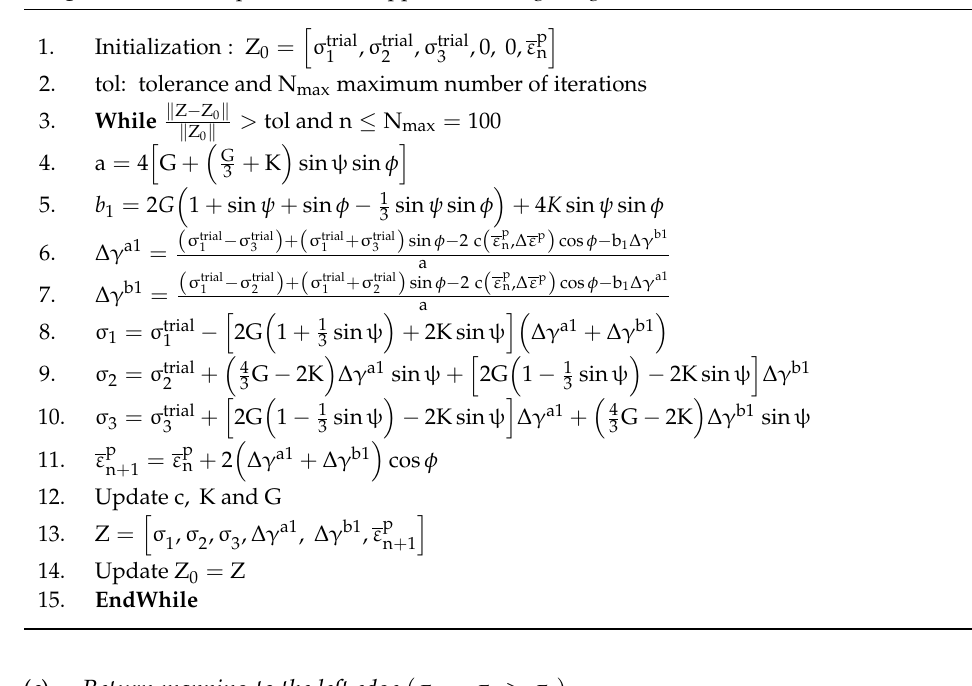
Algorithm 4 : Fixed point method applied to the right edge